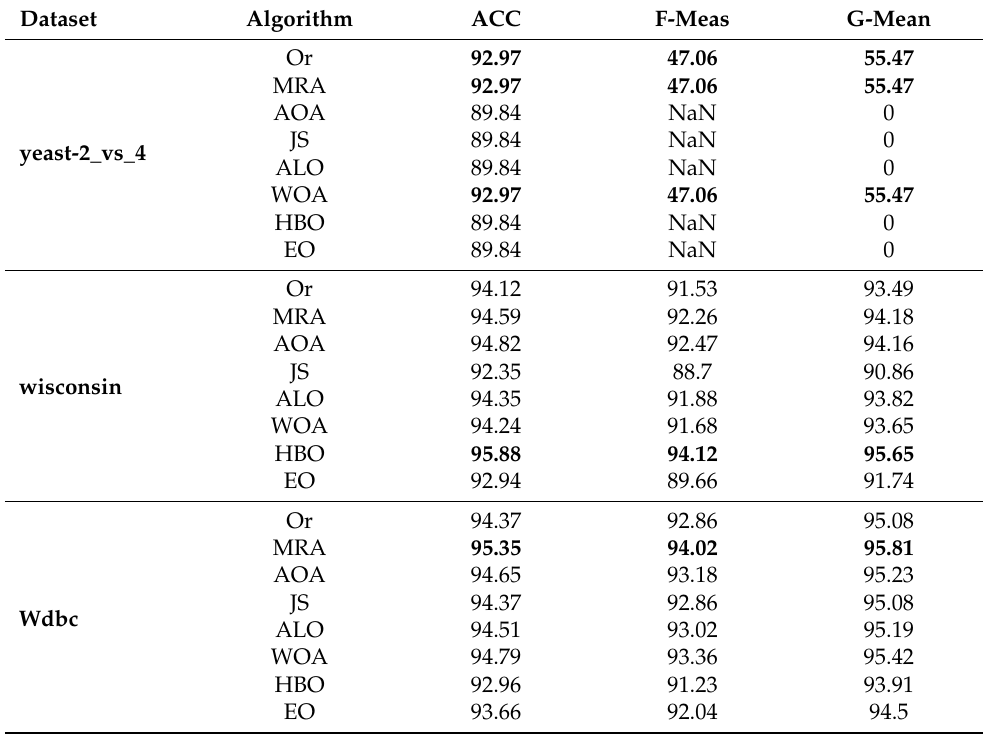
Table 3. Performance measures for real-world